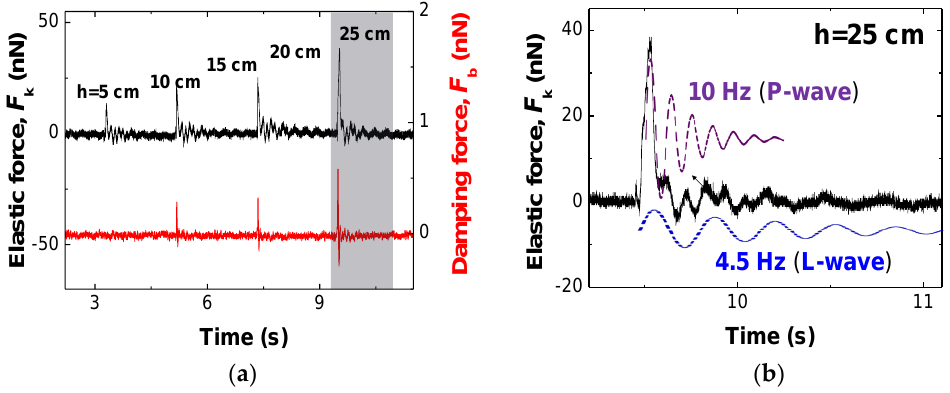
Figure 4. Detection of polarization-dependent sensitive mechanical disturbances: ( a ) after the buckling cantilever placed on the region of bifurcation for continuous detection, we sense continuously the signals of F k and F b generated by the disturbances from the nearby impact spot where a coin (mass of ~5.5 g) is dropped at four different release heights (10 cm and 25 cm), corresponding to the higher impact strength for the latter case; ( b ) magnified graph of 25 cm case. Two orthogonally polarized mechanical waves are simultaneously detected at different oscillation frequencies, P-wave (10 Hz) and L-wave (4.5 Hz), propagating through the massive stage system on which the buckling-tip sensor is tightly fixed, as shown in the detailed temporal responses given in each lower